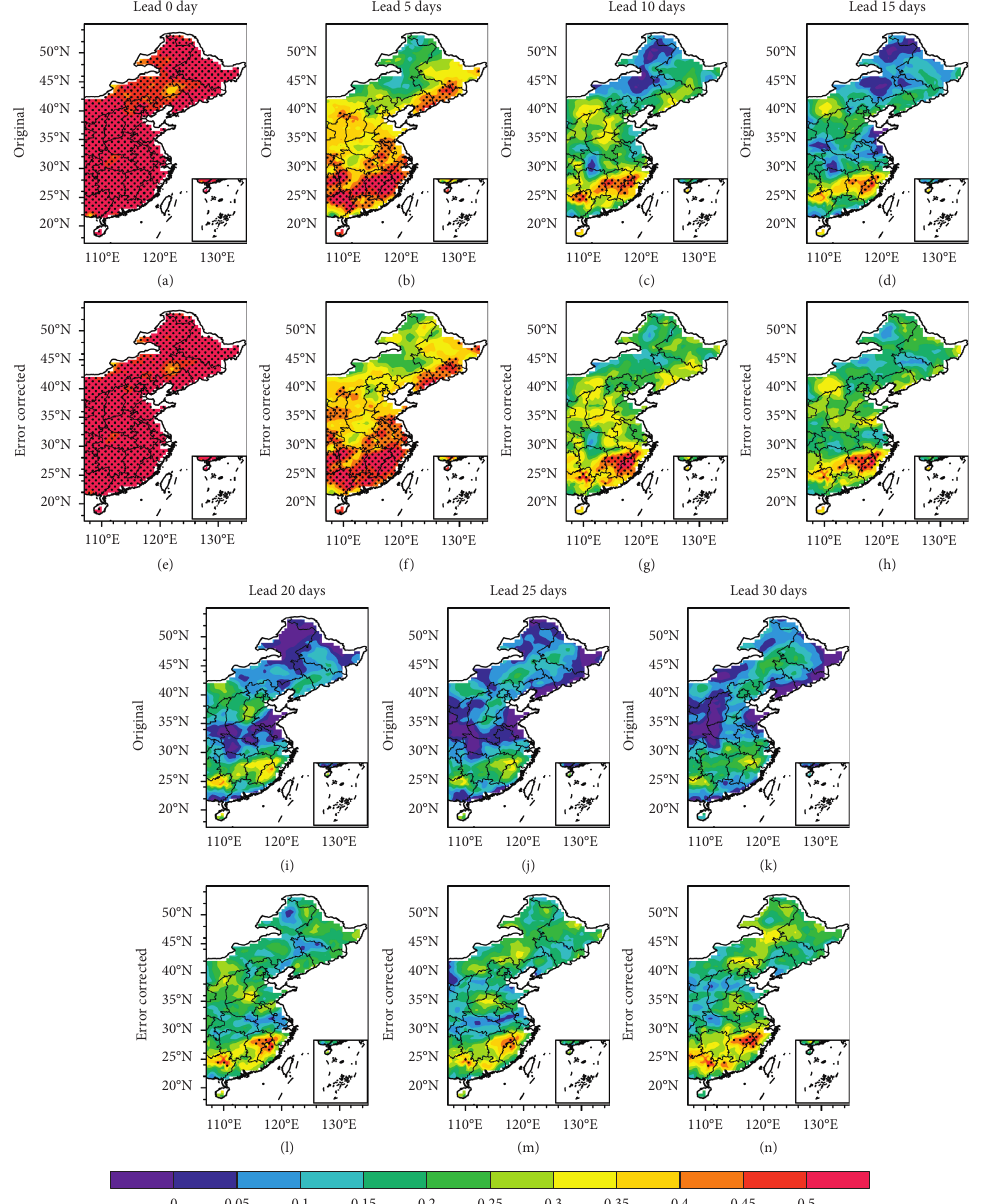
Figure 5: The multiyear average (1995–2014) of the TCC between the ensemble mean and observed summer accumulated ten-day precipitation for error-uncorrected (a–d and i–k) and error-corrected (e–h and l–n) ECMWF S2S hindcast experiment with lead times of 0, 5, 10, 15, 20, 25, and 30 days in the eastern China. The dots represent TCC exceeding 95% confidence level. The lower right part of the figure is an administrative zoning map of the South China